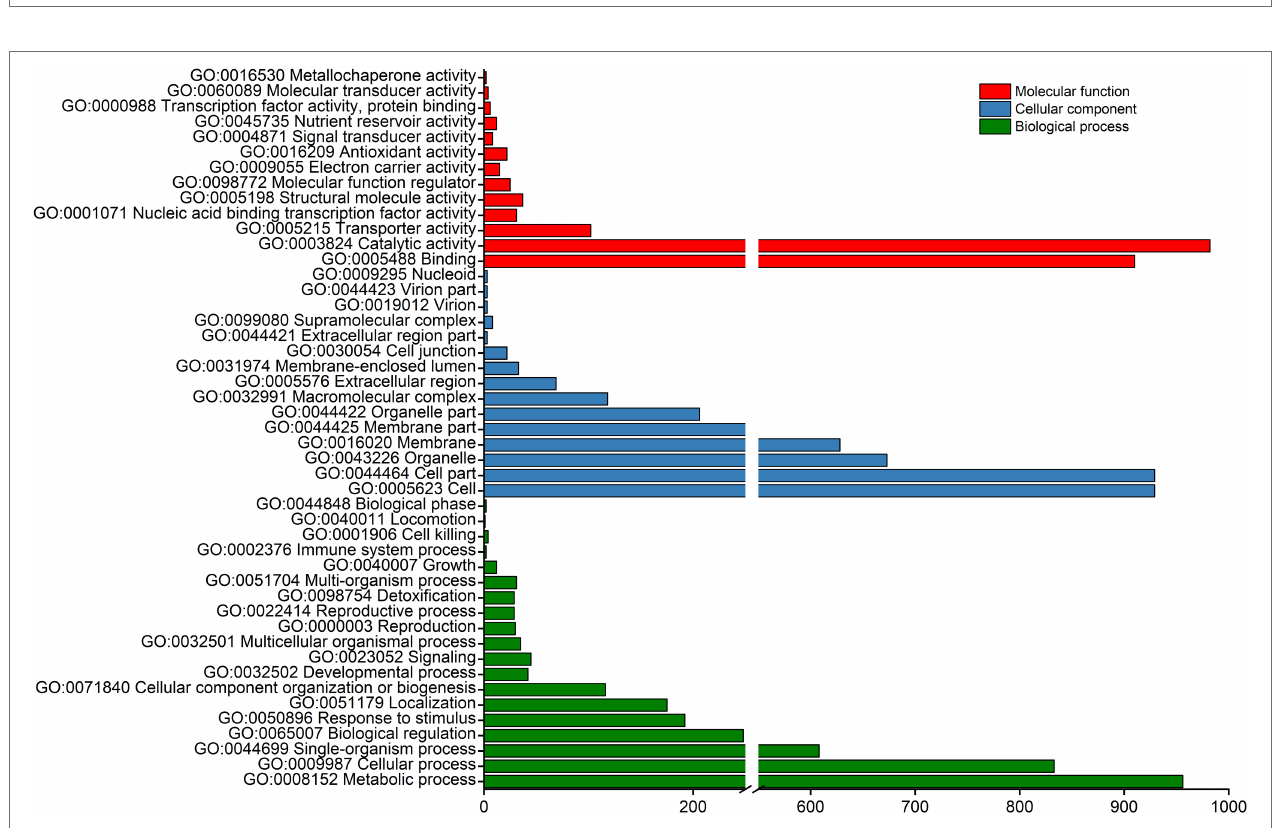
FIGURE 4 | GO enrichment analysis of DEGs. The main GO terms assigned to “biological process,” “cellular component,” and “molecular function” categories are